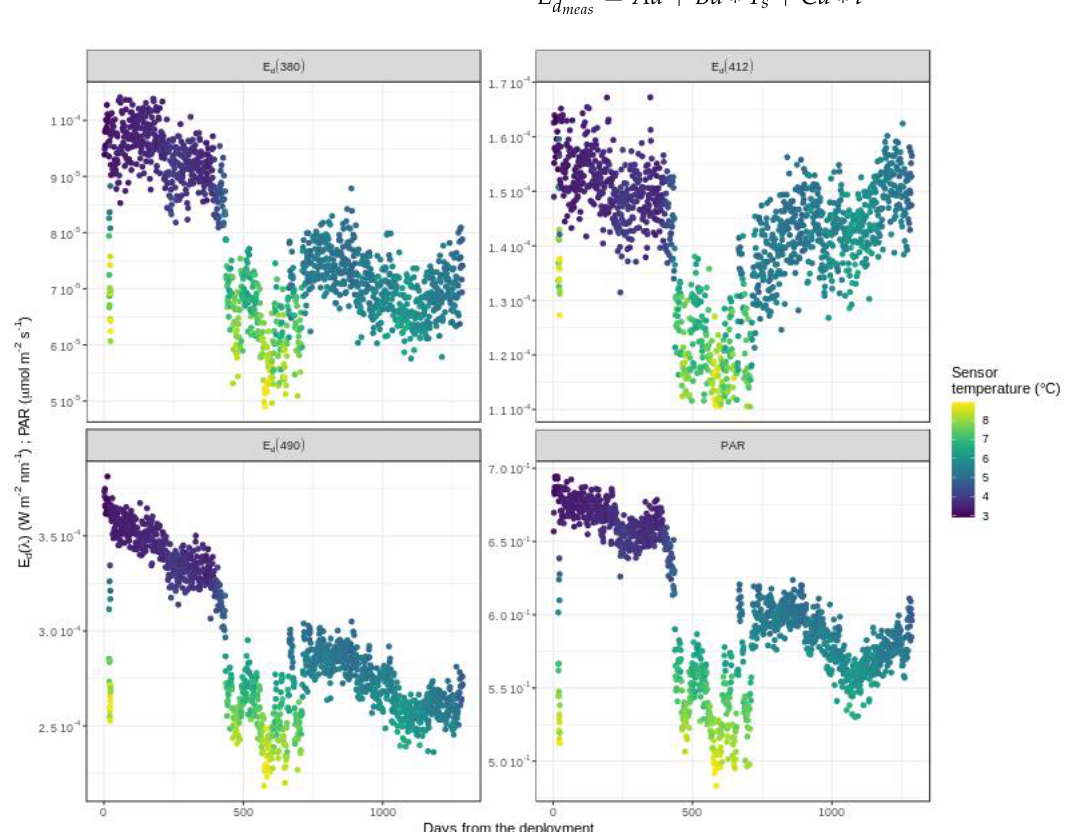
Figure 4. Radiometry drift measurements for E d ( λ ) and PAR as a function of time and temperature. Example is shown for the float